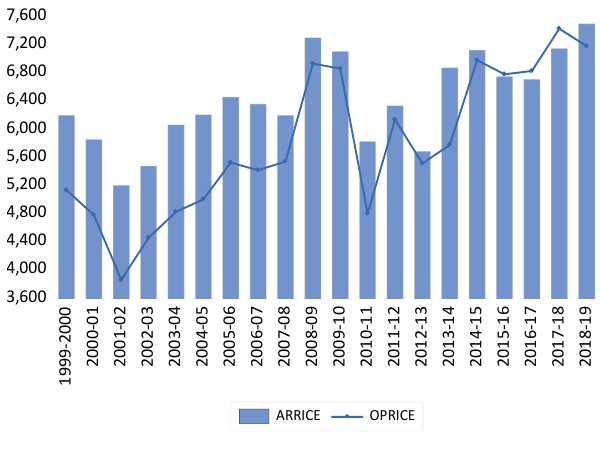
Figure 2: Area and Yield of Rice crops, 1999 –